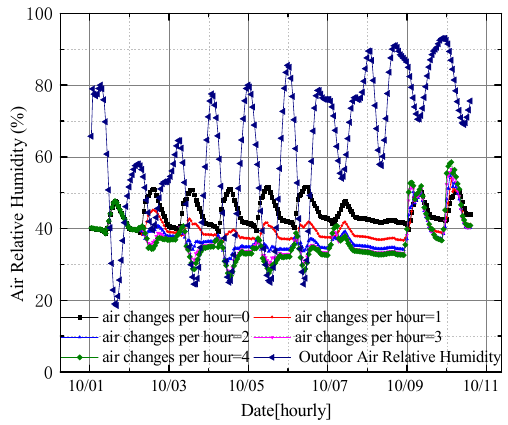
Figure 13. Relative humidity with different air exchange from 1 October to 10 October.